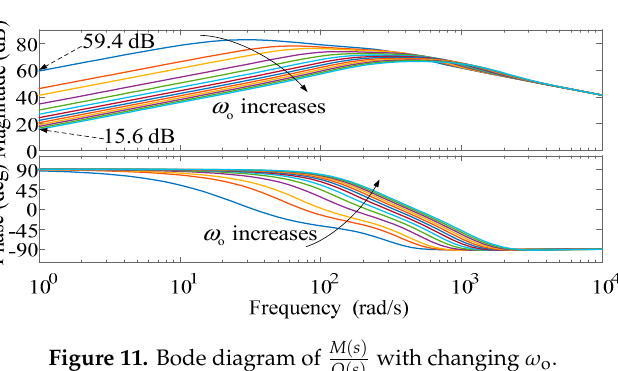
( s ) with changing ω o . Q ( s )